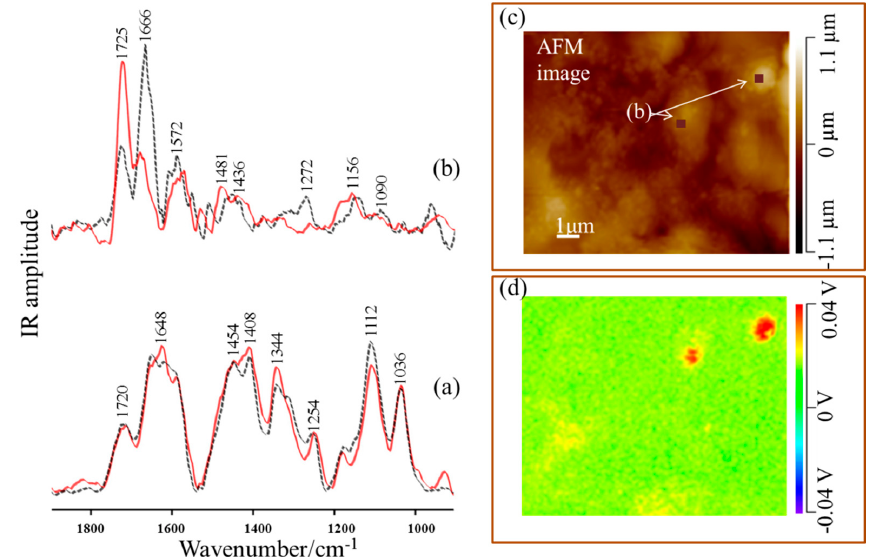
Figure 5. ( a ) Nano-IR spectra of the dried sample of Thr (10 − 1 M/0.5 M HCl); and ( b ) nano-SEIRA spectra of the corroded CuNPs-Fe surface with presence of Thr (10 − 1 M) recorded for p- (black color and dotted line) and s -polarization modulation (red color and solid line) in the spectral range of 1900– 900 cm − 1 ; ( c ) AFM image of Thr 10 − 1 M adsorbed onto the CuNPs-Fe surface; ( d ) the intensity map